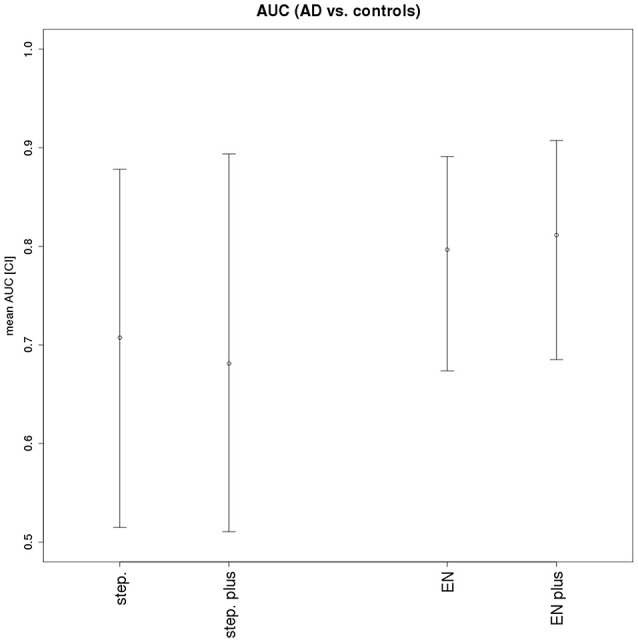
Areas under the ROC curves for stepwise and elastic net logistic regression. AUC and 2.5/97.5 percentile confidence intervals for stepwise logistic regression without scanner (step.) and with scanner forced into the model (step. plus), and for elastic net logistic regression without scanner (EN) and with scanner forced into the model (EN plus).